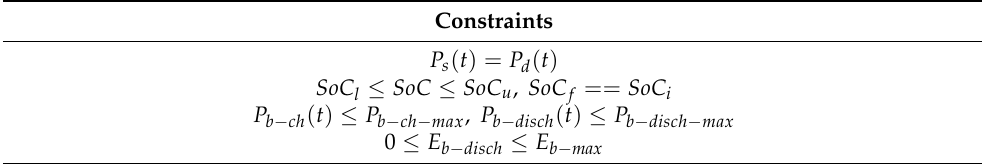
Table 6. Constraints for the genetic